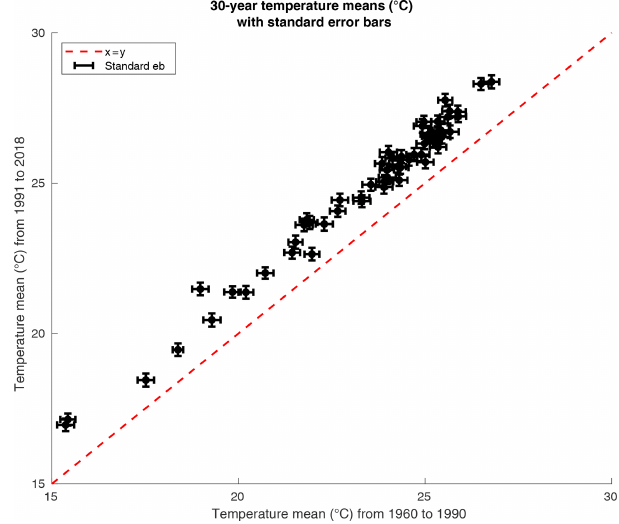
Figure 8. Scatter plot illustrating the difference in mean summer temperature taken over the period from 1960 to 1990 ( x axis) and from 1991 to 2018 ( y axis) with standard error bars. All values and standard error bars are located above the